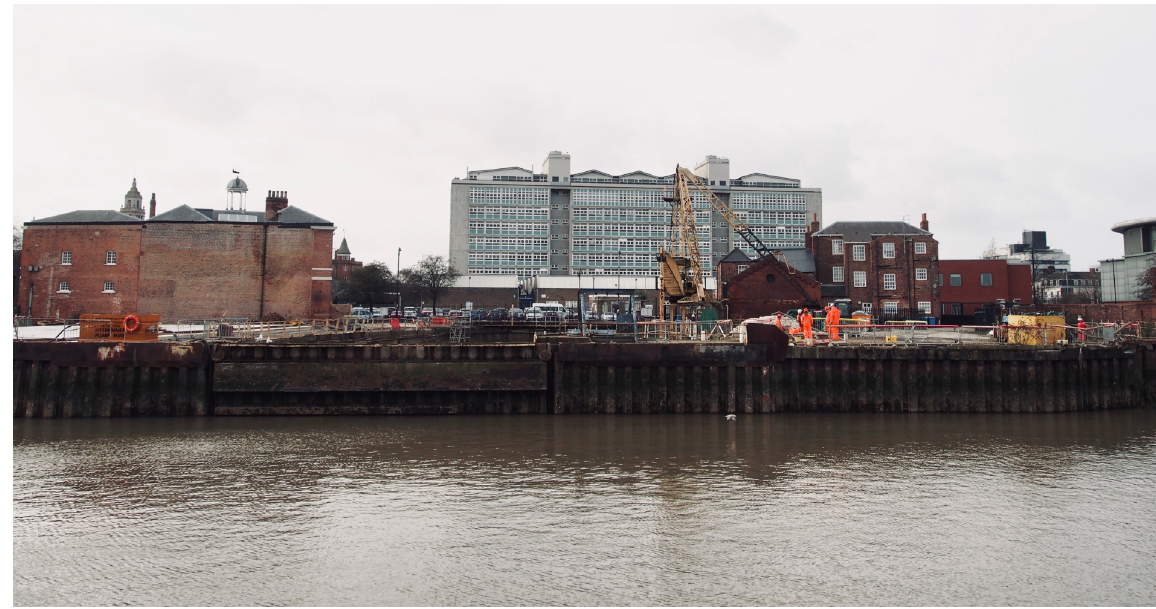
Yorkshire Maritime City masterplan breaks ground along the Hull riverbank to host the Arctic Corsair, a deep-sea trawler which was turned into a museum, original photo by author,